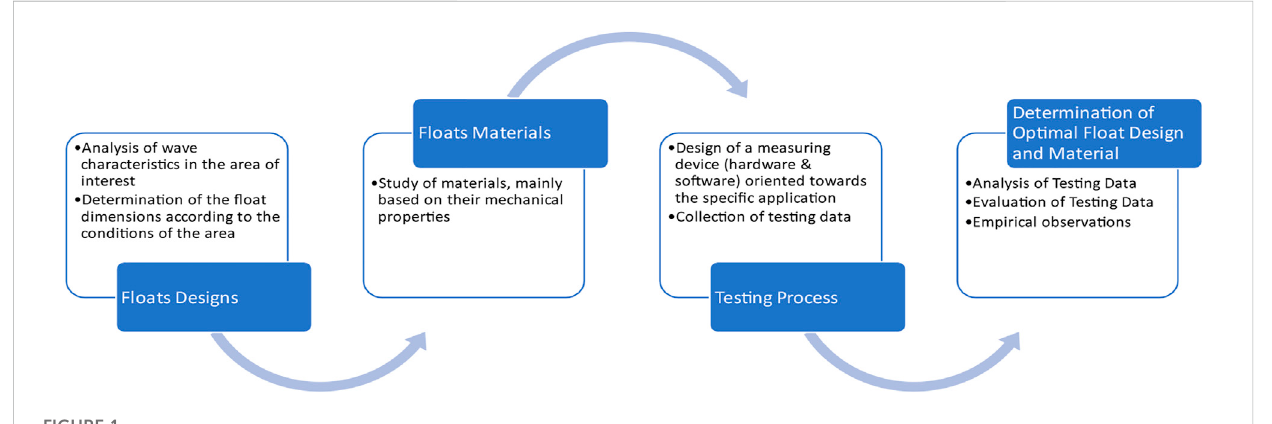
FIGURE 1 Process of selecting the optimal design and material for the fl